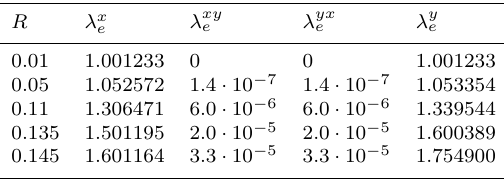
Table 4. The components of the effective conductivity tensor Λ e for the configuration of the inclusions given in (4.1) for the material constants λ k = 100, γ k = 100, β k = − 0 . 01, M =